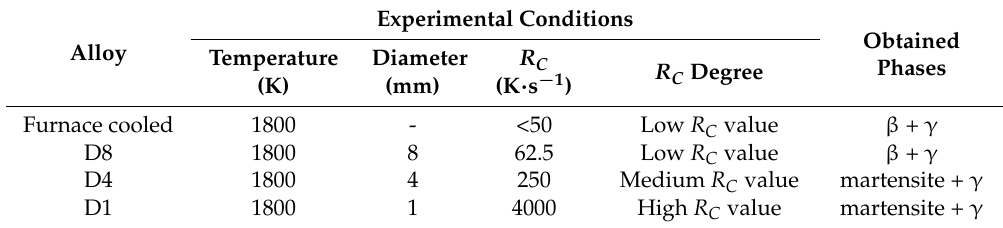
Table 3. The experimental conditions and obtained phases of Co 33 Ni 31 Al 27 Fe 9 alloy with furnace cooled and RS.